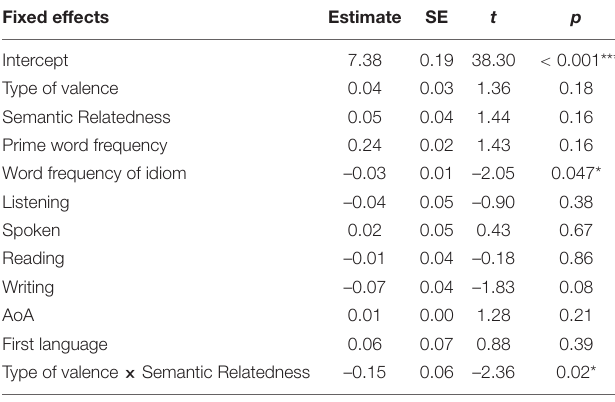
TABLE 9 | Model parameters in the mixed-effect model for RTs in Experiment 2.